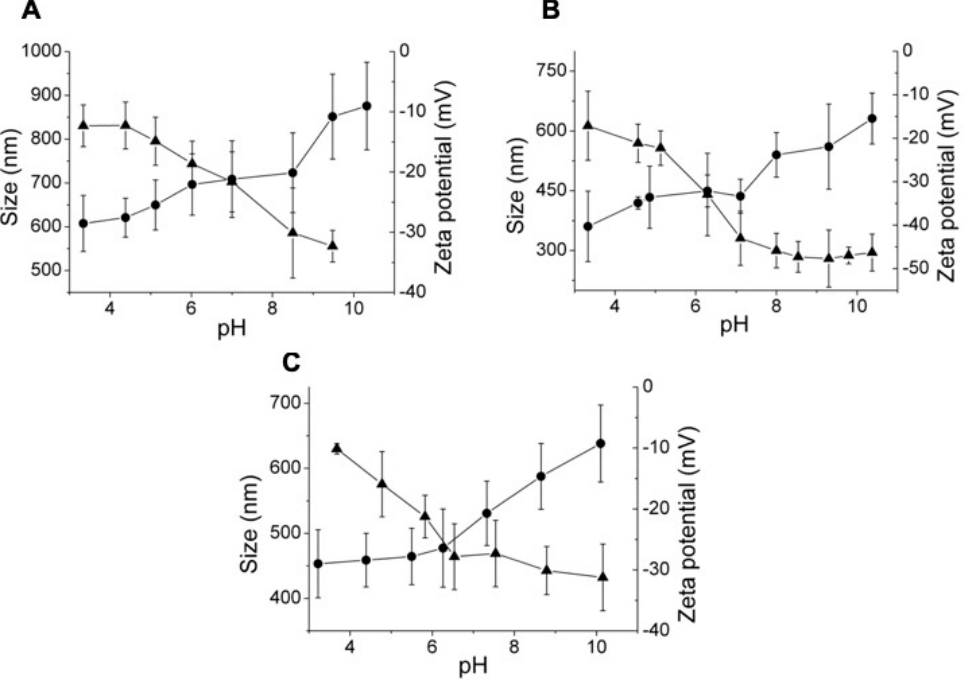
Figure 5. Variation of the hydrodynamic diameter ( ● ) and the zeta potential ( ▲ ) of HA (2.1MDA) nanogels prepared by crosslinking (1:1, HA:crosslinker molar ratio) with ( A ) DVS, ( B ) BDDE, and ( C ) PEGBNH 2 .